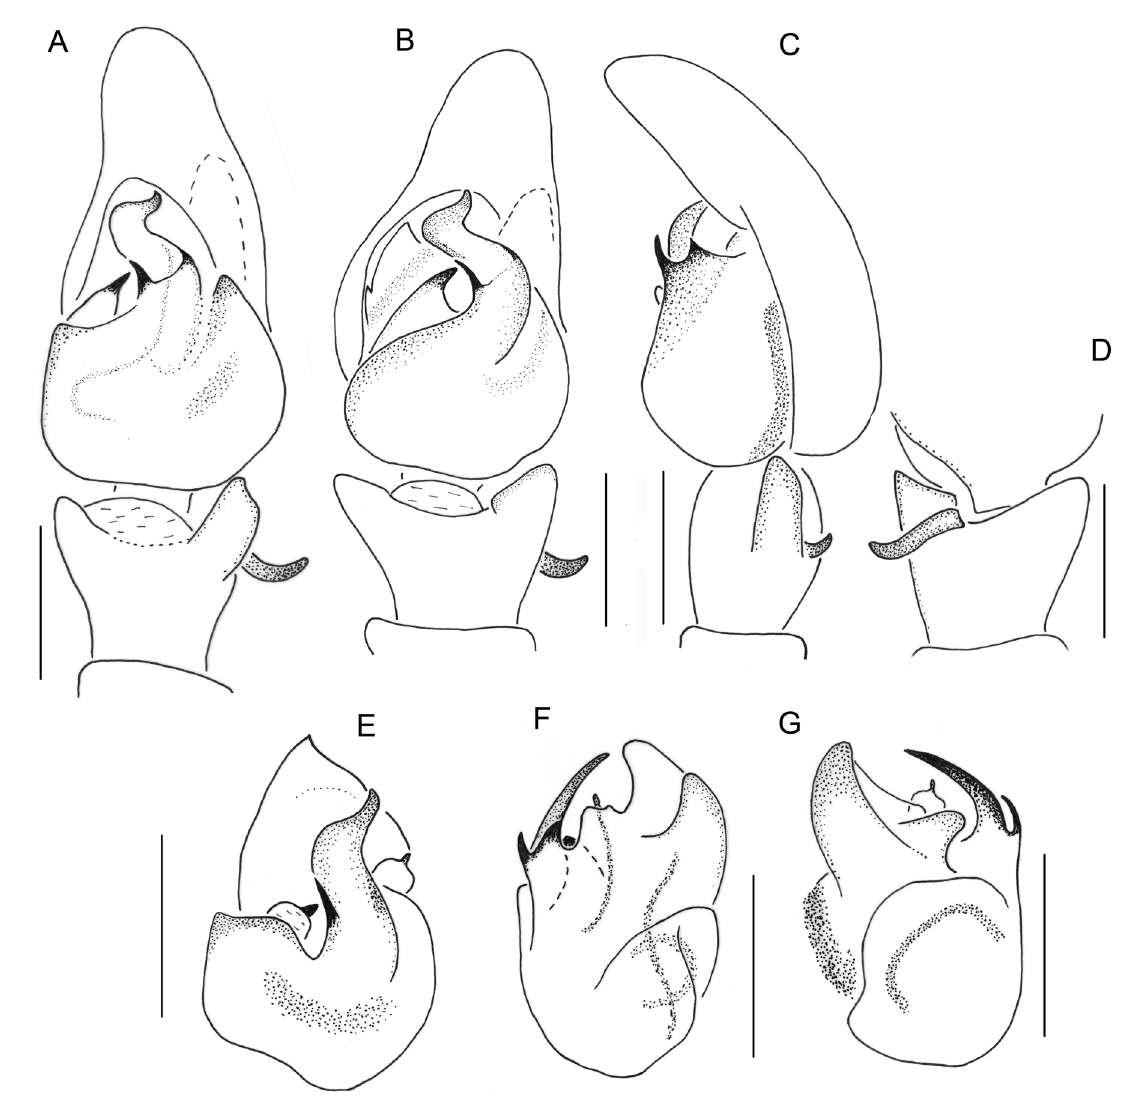
Fig. 13. Pochytoides spiniger sp. nov., paratypes, ♂. A–C . Palpal organ. A . Ventral view. B . Anteroventral view. C . Retrolateral view. D . Palpal apophyses, dorsal view. E–G . separated bulb. E . Ventral view. F . Retrolateral view. G . Prolateral view. scale bar = 0.3